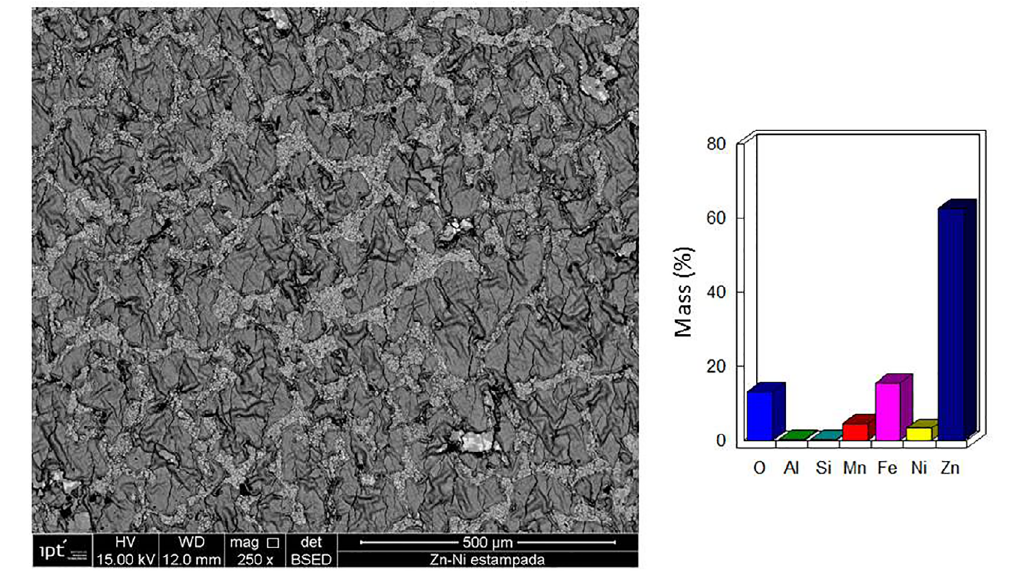
Figure 3. Surface morphology of 22MnB5 steel coated with electroplated with Zn-Ni coating after hot stamping.